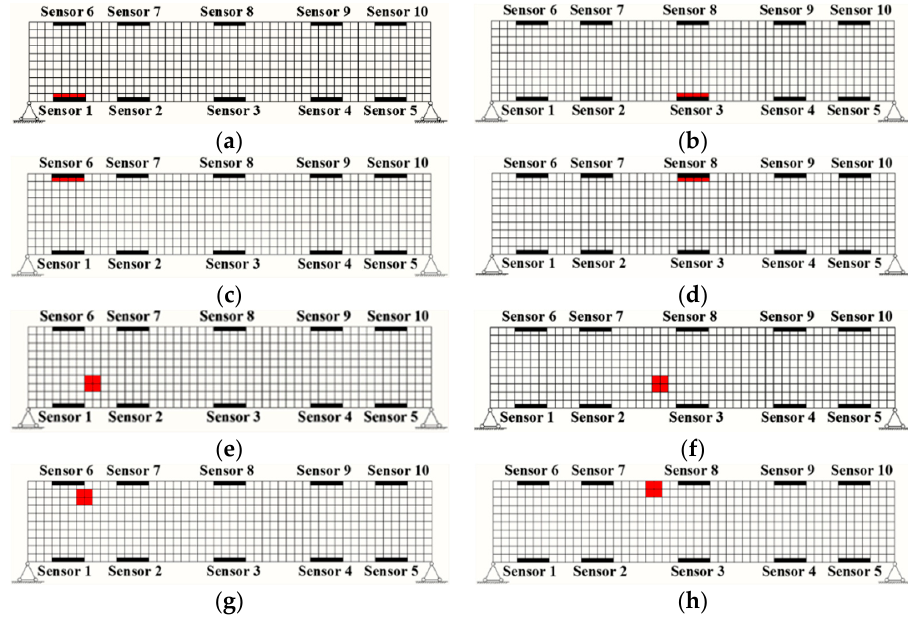
Figure 3. Damaged scenarios for the evaluation of damage detection algorithms: ( a ) damage in four finite elements at Sensor 1; ( b ) damage in four finite elements at Sensor 3; ( c ) damage in four finite elements at Sensor 6; ( d ) damage in four finite elements at Sensor 8; ( e ) damage in four finite elements near Sensor 1; ( f ) damage in four finite elements near Sensor 3; ( g ) damage in four finite elements near Sensor 6; ( h ) damage in four finite elements near Sensor 8.